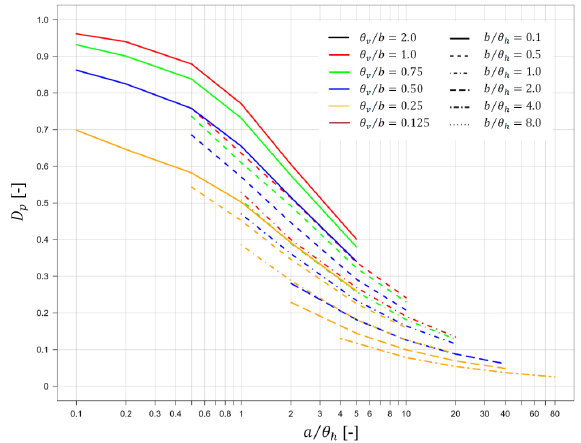
Figure 6: Graph for reading D [ 0.25,0.125 ]. Note that the colour in the legend indicates θ θ ⁄ b v b and the line type (coloured on black in the legend) indicates θ ∈